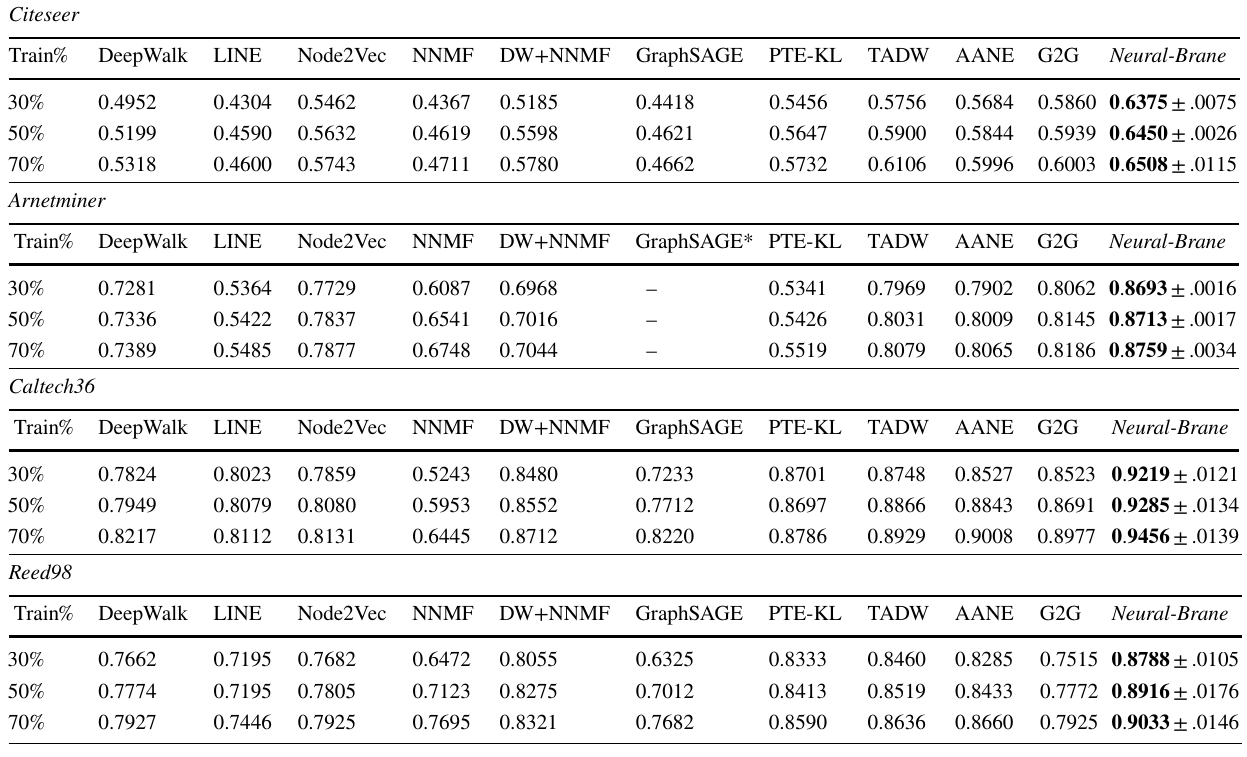
*GraphSAGE for Arnetminer is not able to complete after 2 days